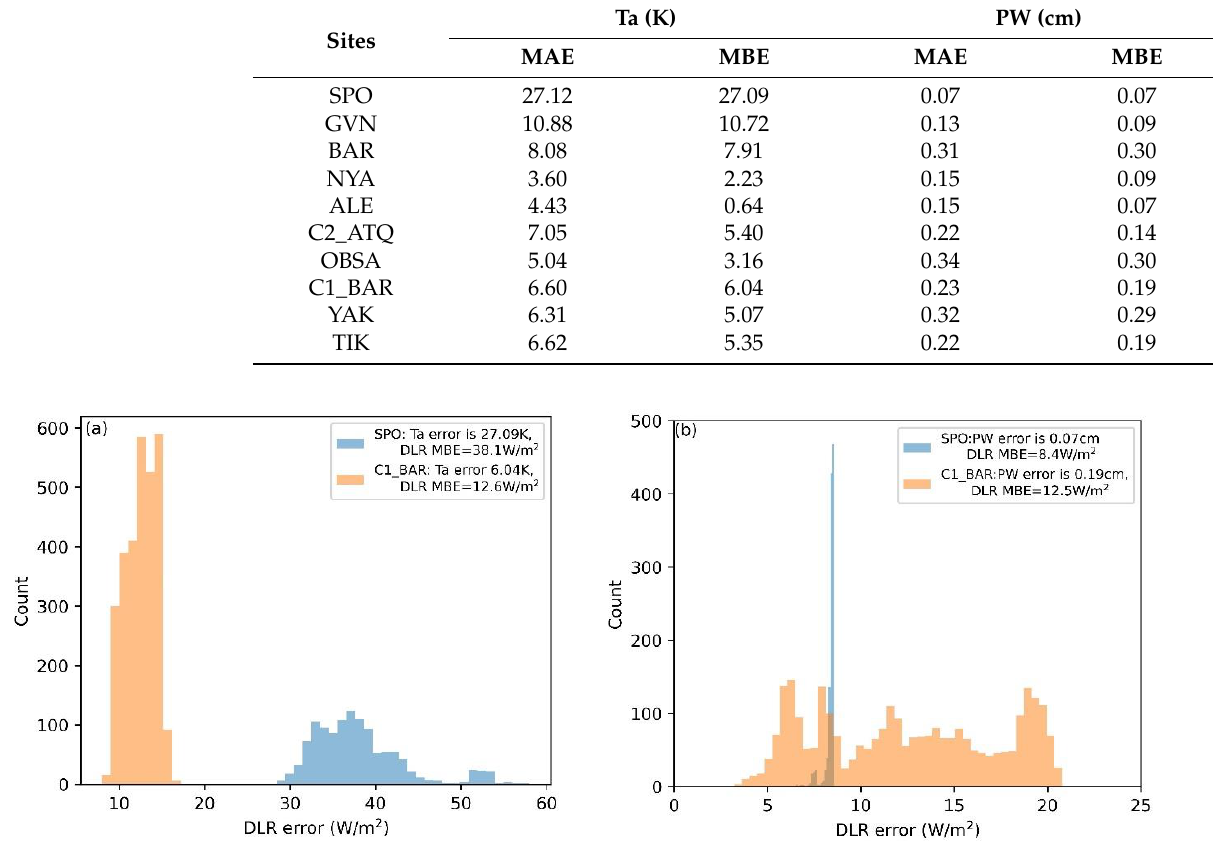
Table 4. MAE and MBE of meteorological parameters in ISCCP.